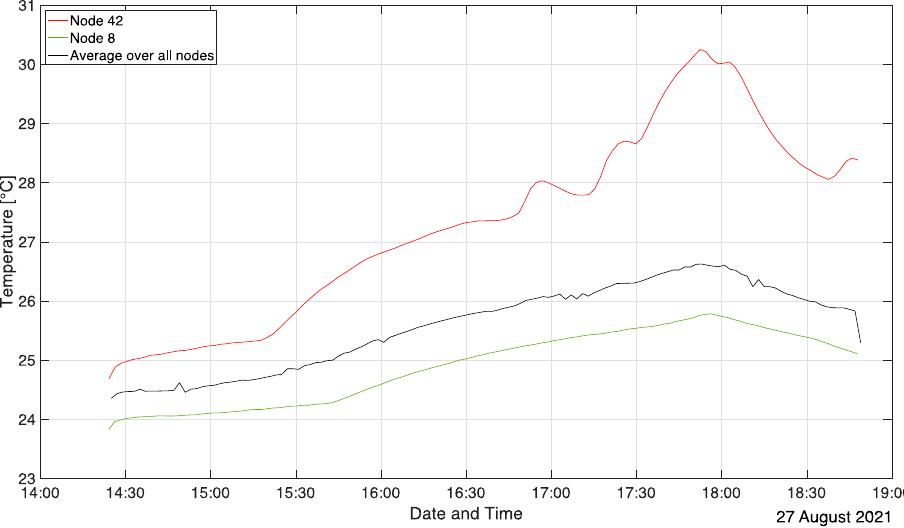
Figure 10. Temperature evolution in the large planar seminar room.